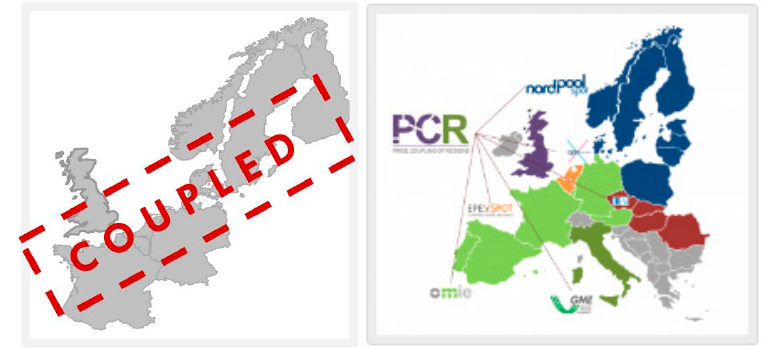
Figure 1. Countries of NWE coupled [10] and Countries of Price Coupling of Regions (PCR) [11].